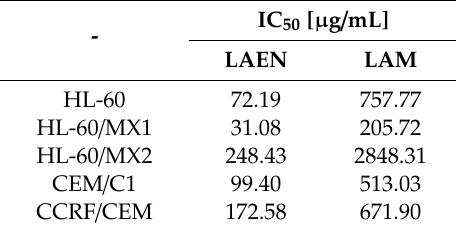
Table 5. The extrapolated IC 50 values for the HL-60, HL-60 / MX1, HL-60 / MX2, CEM / C1, and CCRF / CEM line